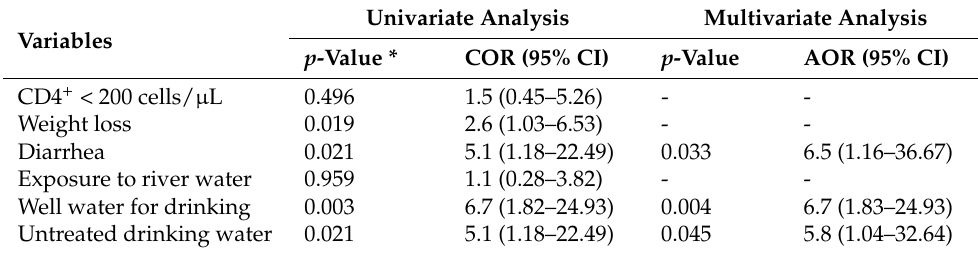
COR: crude odds ratio; AOR: adjusted odds ratio. * chi-square